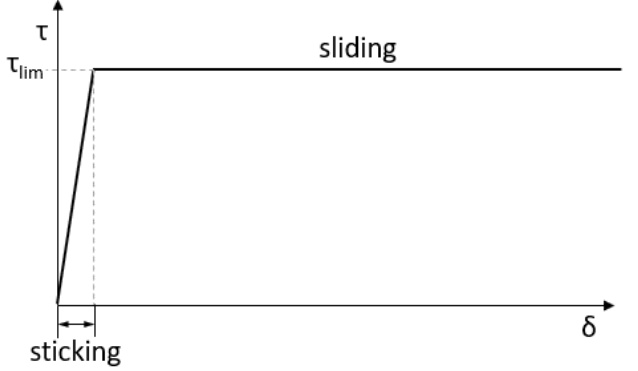
Figure 5. Relation of frictional stress 𝜏 and tangential displacement 𝛿 in the Coulomb friction model, adapted from [30].